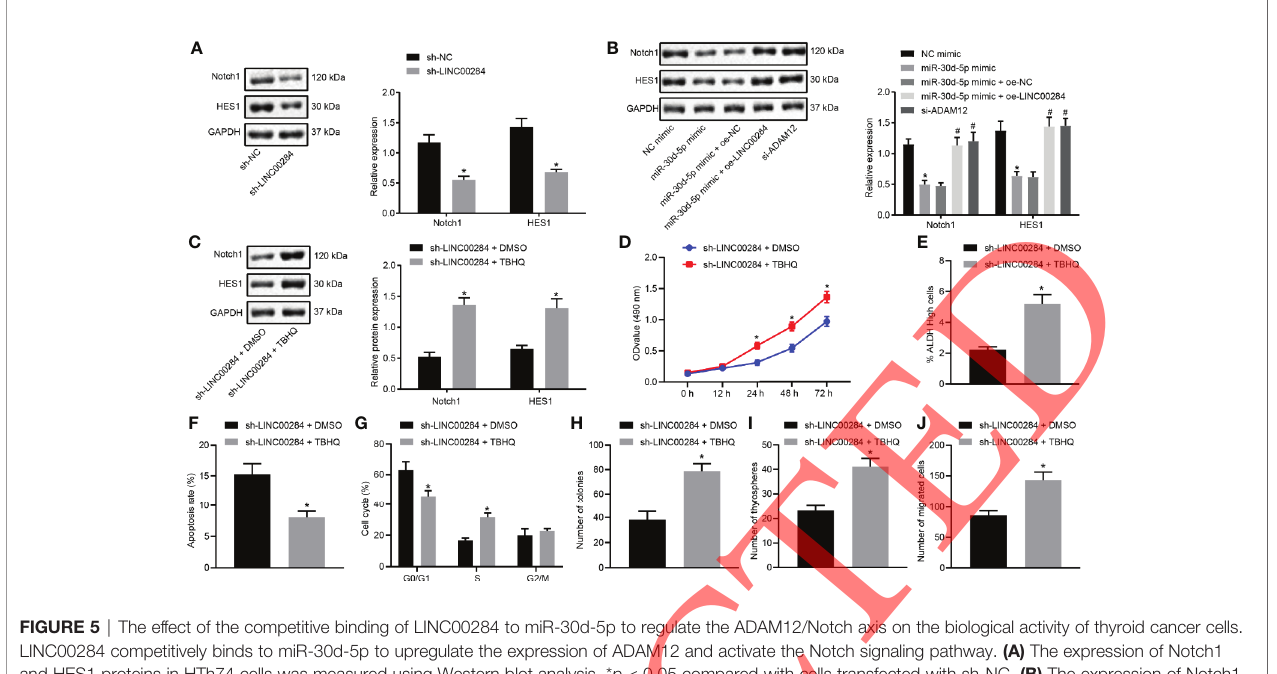
FIGURE 5 | The effect of the competitive binding of LINC00284 to miR-30d-5p to regulate the ADAM12/Notch axis on the biological activity of thyroid cancer cells. LINC00284 competitively binds to miR-30d-5p to upregulate the expression of ADAM12 and activate the Notch signaling pathway. (A) The expression of Notch1 and HES1 proteins in HTh74 cells was measured using Western blot analysis, * p < 0.05 compared with cells transfected with sh-NC. (B) The expression of Notch1 and HES1 proteins in C643 cells was measured using Western blot analysis, * p < 0.05 compared with cells transfected with sh-NC or NC mimic, # p < 0.05 compared with cells transfected with miR-30d-5p mimic + oe-NC. (C) The expression of Notch1 and HES1 proteins in HTh74 cells was measured using Western blot analysis. (D) The viability of HTh74 cells was determined using the MTT assay. (E) The ALDH activity of HTh74 cells determined in the ALDEFLUOR experiment. (F) Flow cytometry analysis of the cell cycle of HTh74 cells. (G) Flow cytometry analysis of the apoptosis of HTh74 cells. (H) The colony formation ability of C643 cells. (I) Self-renewal ability of C643 cells assessed using the cell sphere formation assay. (J) The invasive ability of C643 cells assessed using the Transwell assay. * p < 0.05 compared with cells treated with sh-LINC00284 + DMSO. Measurement data are presented as the means ± standard deviations. Comparisons between two groups were analyzed using the unpaired t -test, comparisons among multiple groups were analyzed using one-way ANOVA followed by Tukey ’ s post hoc test, and comparisons among groups at different time points were analyzed using repeated measures ANOVA with Tukey ’ s post hoc test. The experiments were repeated three